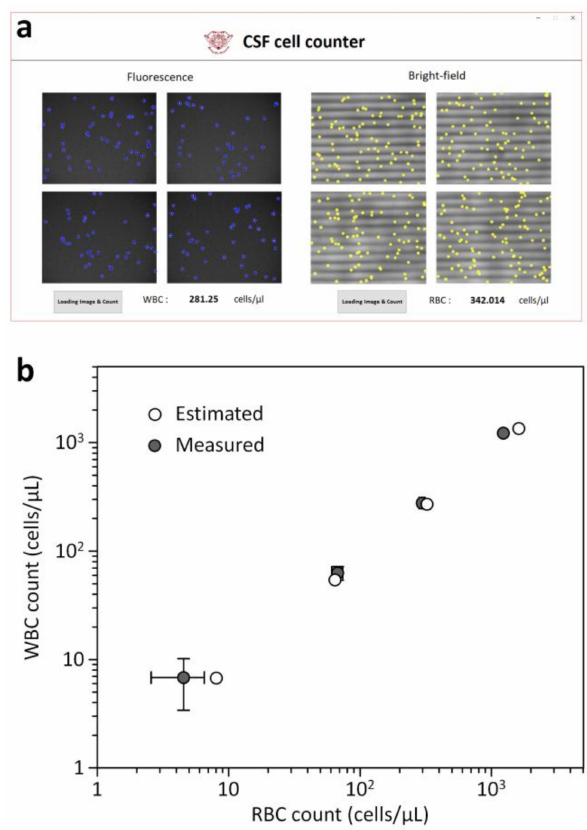
Figure 7. Blood cell counts in model CSF samples. ( a ) Custom Matlab GUI and cell counting program. Blood cells in bright-field and fluorescence images were overlaid with circle symbols for visualization. ( b ) The RBC and WBC counts of model CSF samples were automatically measured with the counting program and were highly correlated with the cell counts estimated with a standard hemocytometer.